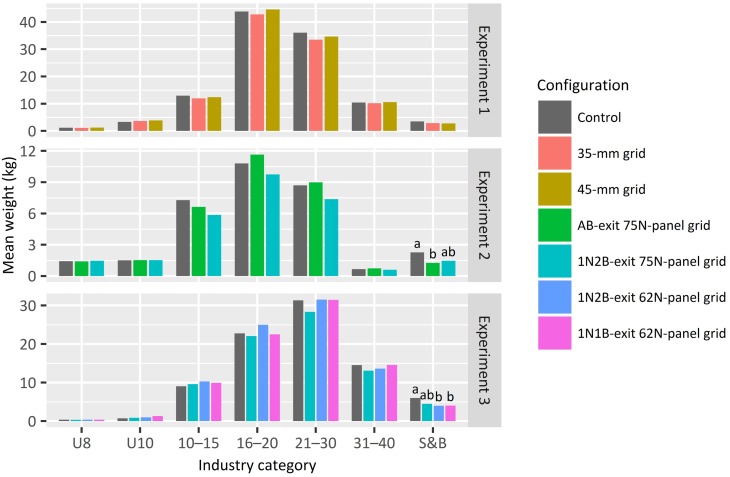
Predicted mean industry category weights 30 min–1 of Melicertus latisulcatus by configuration for experiments 1 (assessing bar spaces), 2 (assessing escape-exit area) and 3 (assessing escape area and guiding panel length).Where there was a significant effect (p < 0.05) among configurations within an experiment, letters above bars denote the false-discovery-rate (FDR) adjusted pairwise comparisons (p < 0.05).